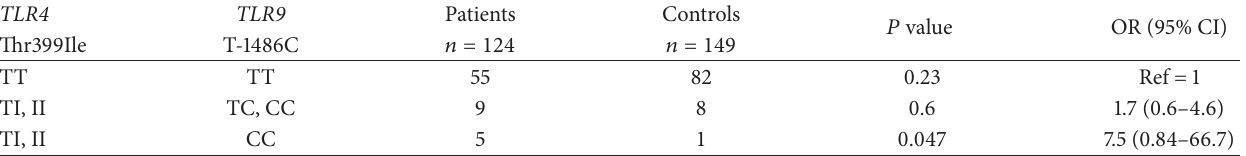
Table 5: Combined effect of both TLR4 Thr399Ile and TLR9 T-1486C polymorphisms in cases and